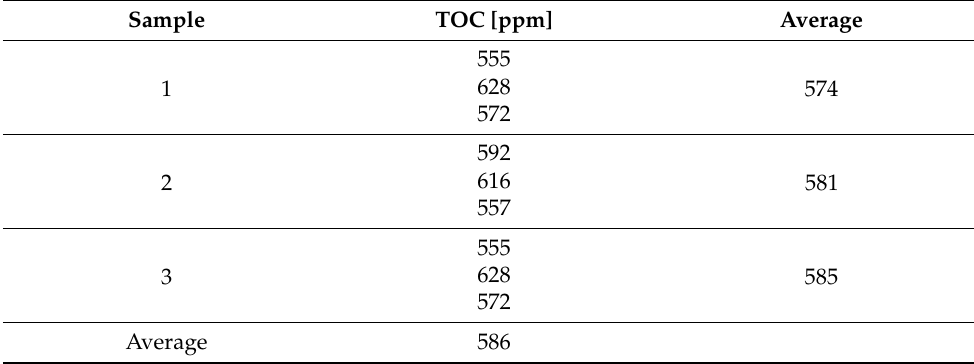
Table 2. TOC analysis results for mixed waste